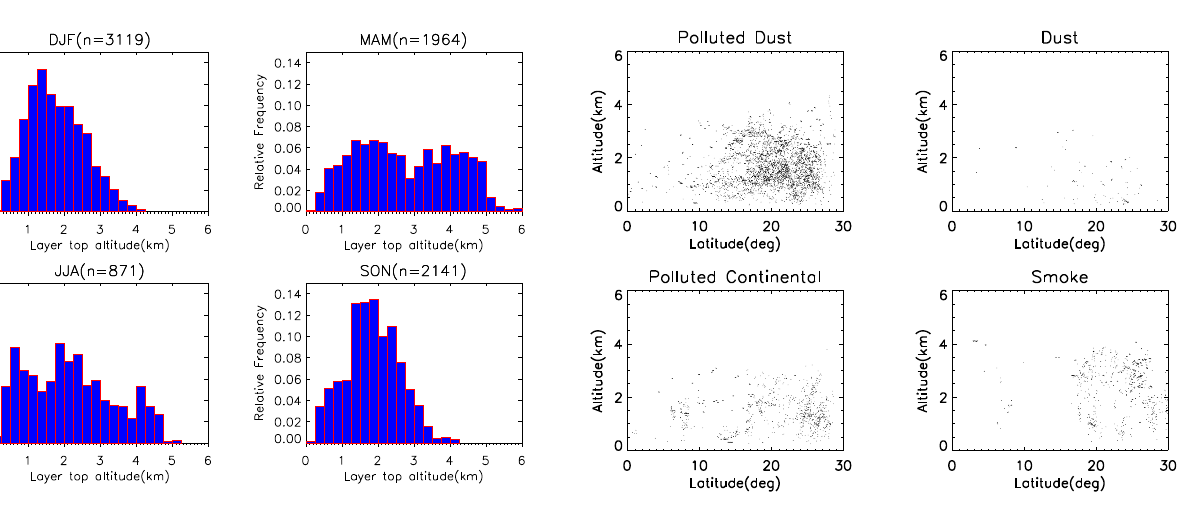
Fig. 9. Altitude distribution of the layers of dominant aerosol sub- types along 80 ◦ E-90 ◦ E between December 2006 and February 2007. Altitudes refer to top of the layers above the